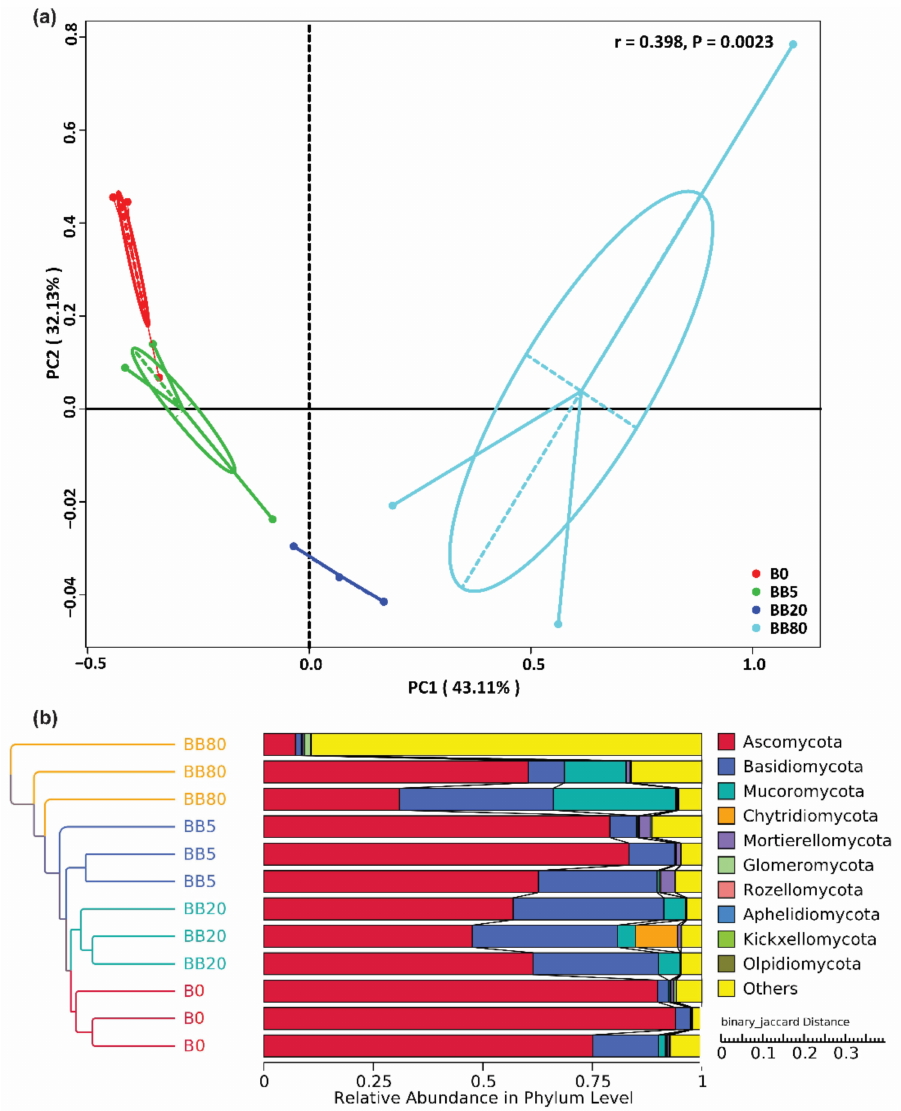
Figure 4. Changes in soil fungal community composition. ( a ) Unweighted UniFrac principal co- ordinate analysis (PCoA) showing differences in fungal communities; ( b ) Unweighted pair group method with arithmetic mean analysis (UPGMA) of fungal communities. B0, BB5, BB20, and BB80 represent different bamboo biochar concentrations of 0, 5, 20, and 80 g kg − 1 ,